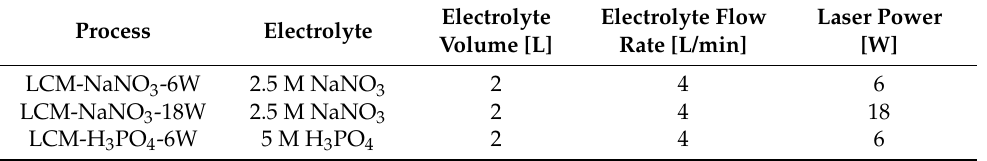
Table 2. LCM process